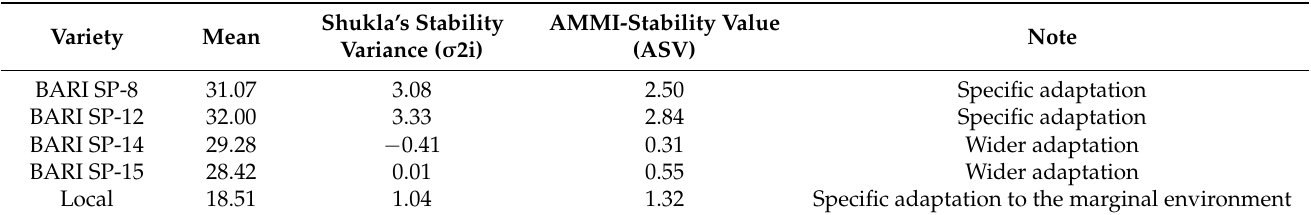
Table 10. AMMI analysis provides stability parameters for tuber yield in sweet potato.